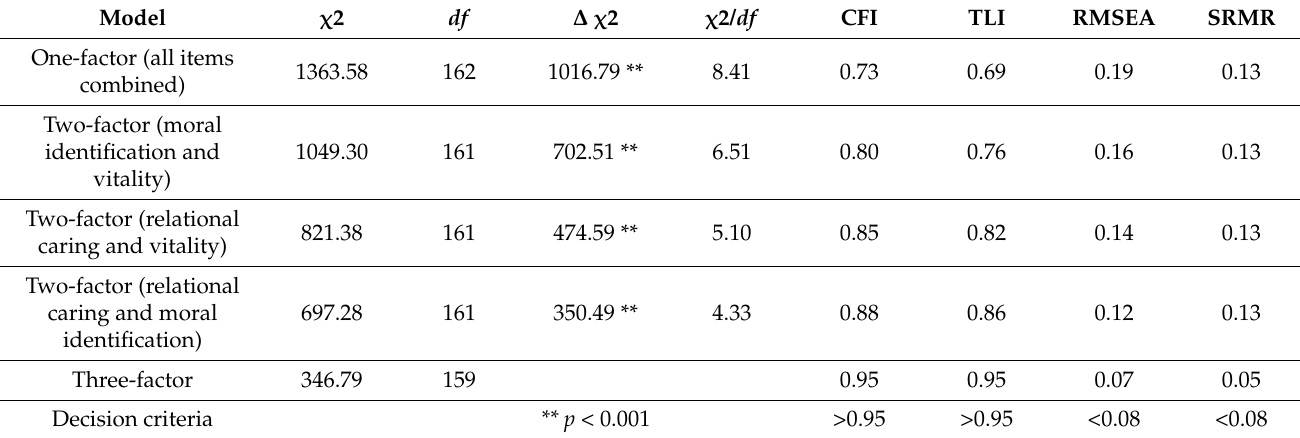
Table 2. A result of measurement model